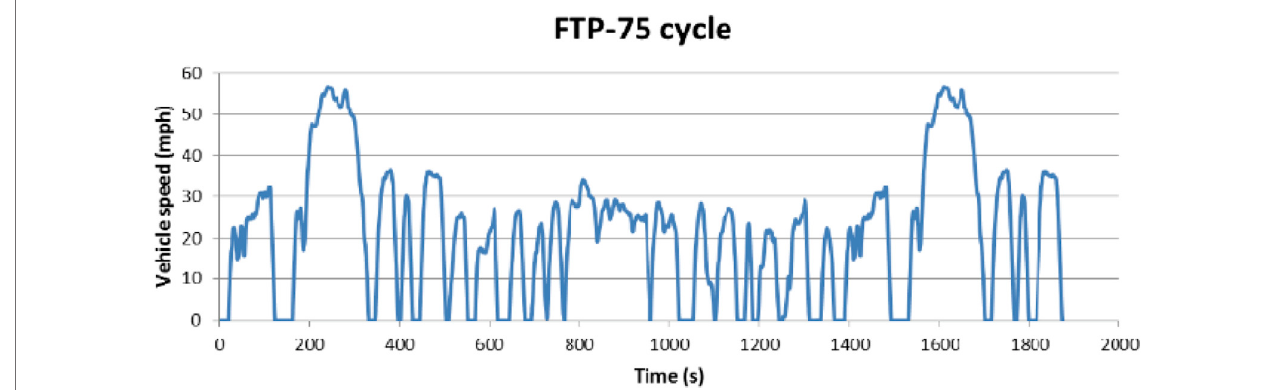
FIGURE 9 | Vehicle speed using FTP-75 drive cycle.